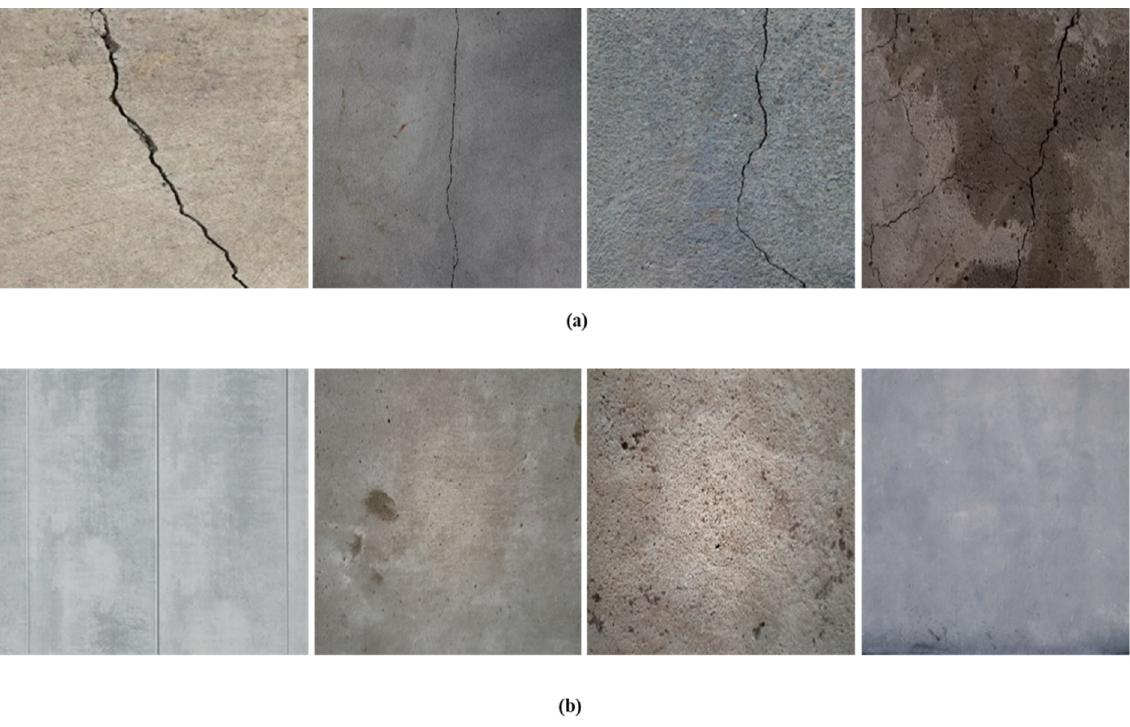
Figure 7. ( a ) Cracked concrete wall images ( b ) Non-cracked concrete wall images.